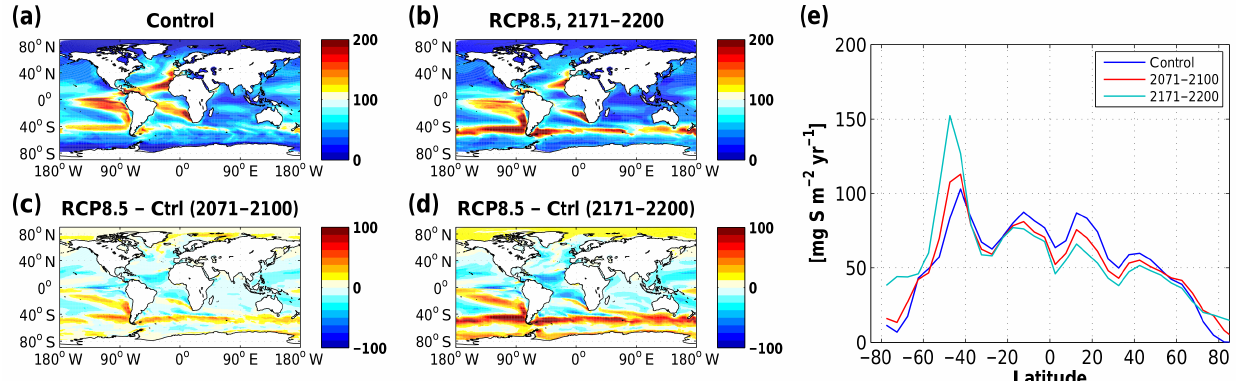
Figure 3. Modelled sea–air DMS fluxes (mgSm − 2 yr − 1 ) in (a) the control run and (b) the RCP8.5 scenario simulation BASE (no sensitivity of DMS production to pH) towards the end of the 22nd century (2171 to 2200). Panels (c) and (d) display the change in sea–air DMS fluxes in the RCP8.5 scenario BASE relative to the control simulation towards the end of the 21st (2071 to 2100) and 22nd (2171 to 2200) century, respectively. Panel (e) shows the zonal mean sea–air DMS fluxes in the control and RCP8.5 simulations.